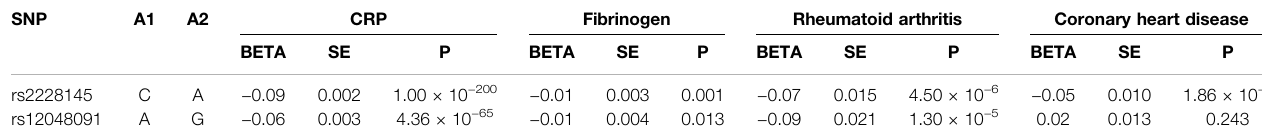
TABLE 2 | Genetic associations with serum CRP and fi brinogen levels and two positive controls (rheumatoid arthritis and coronary heart disease). SNP A1 A2 CRP Fibrinogen